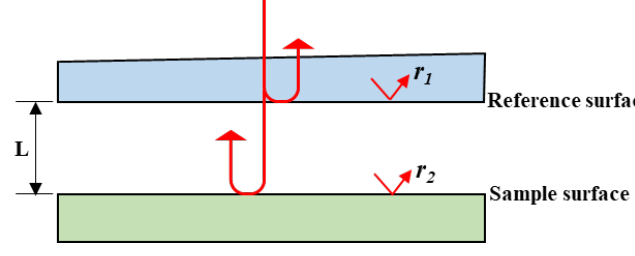
Figure 2. The reflections between surfaces.